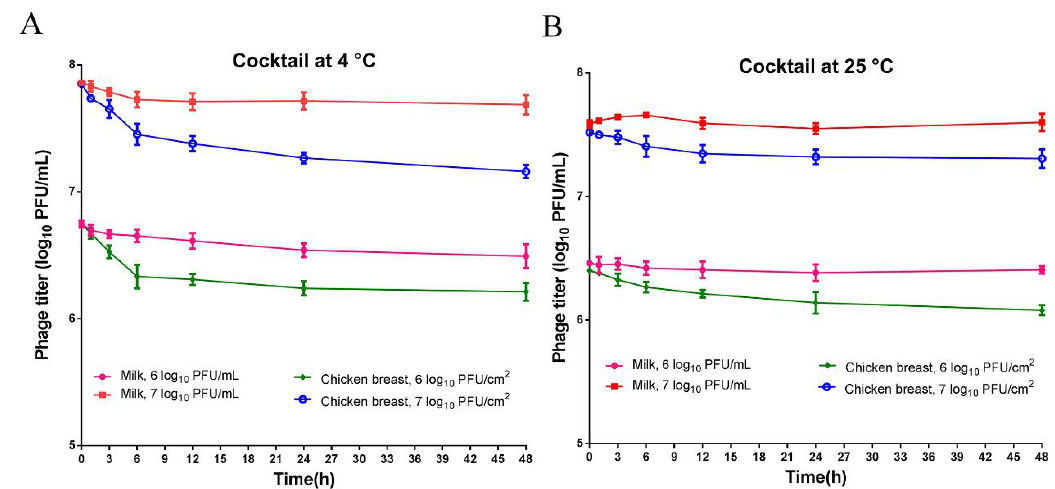
Figure 3. Stability of phage cocktail in foods (milk and chicken breast). Phage cocktail titer of 6 log 10 PFU / mL and 7 log 10 PFU / mL, incubated for 48 h at 4 ◦ C ( A ) and 25 ◦ C ( B ). Values represent mean with standard deviation of three replicates of each time